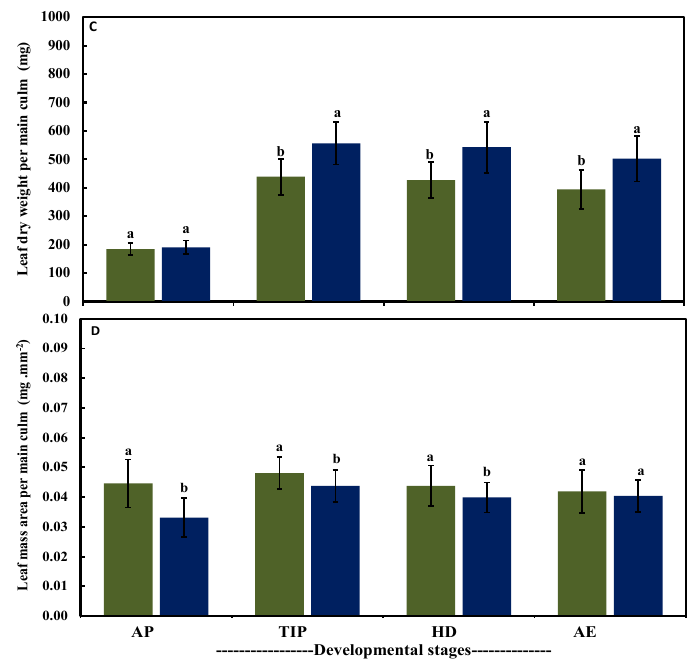
Figure 3. Leaf traits per main culm at four developmental stages for two- and six-rowed barley averaged across all growth conditions. ( A ) Leaf number; ( B ) leaf area; ( C ) leaf dry weight; and ( D ) leaf mass area. The same letters at each developmental stage are not significantly different at p ≤ 0.05 according to the Least Significant Difference. Bars indicate standard deviation ( n = 42 (14 accessions × 3 replicates) and 54 (18 accessions × 3 replicates) for two- and six-rowed barley, respectively). AP: awn primordium, Alqudah and Schnurbusch [30]; TIP: tipping, Z49; HD: heading, Z55; AE: anther extrusion, Z65, Zadoks et al. [34].